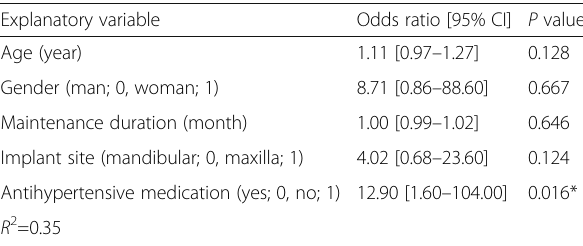
Table 5 Logistic regression analysis for peri-implantitis as the objective